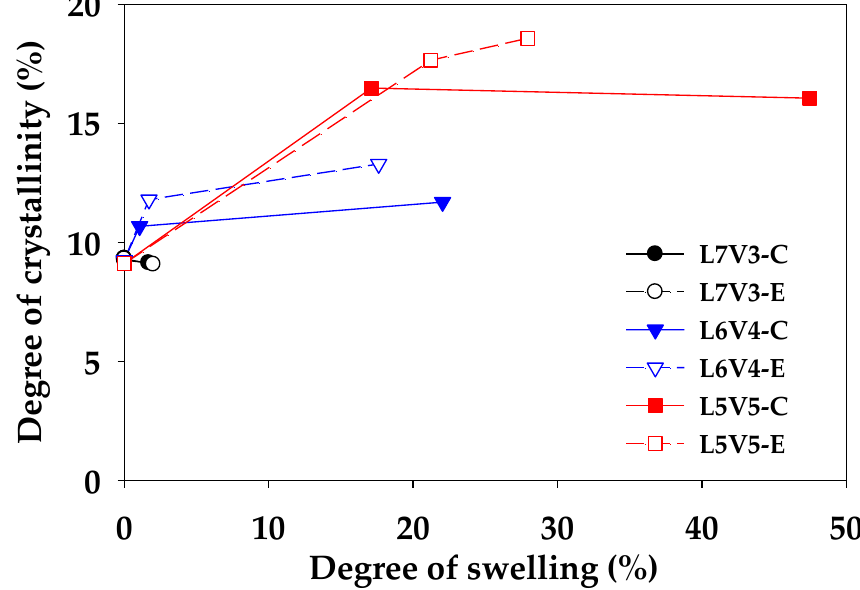
Figure 15. Relationship between the degree of crystallinity and degree of swelling.